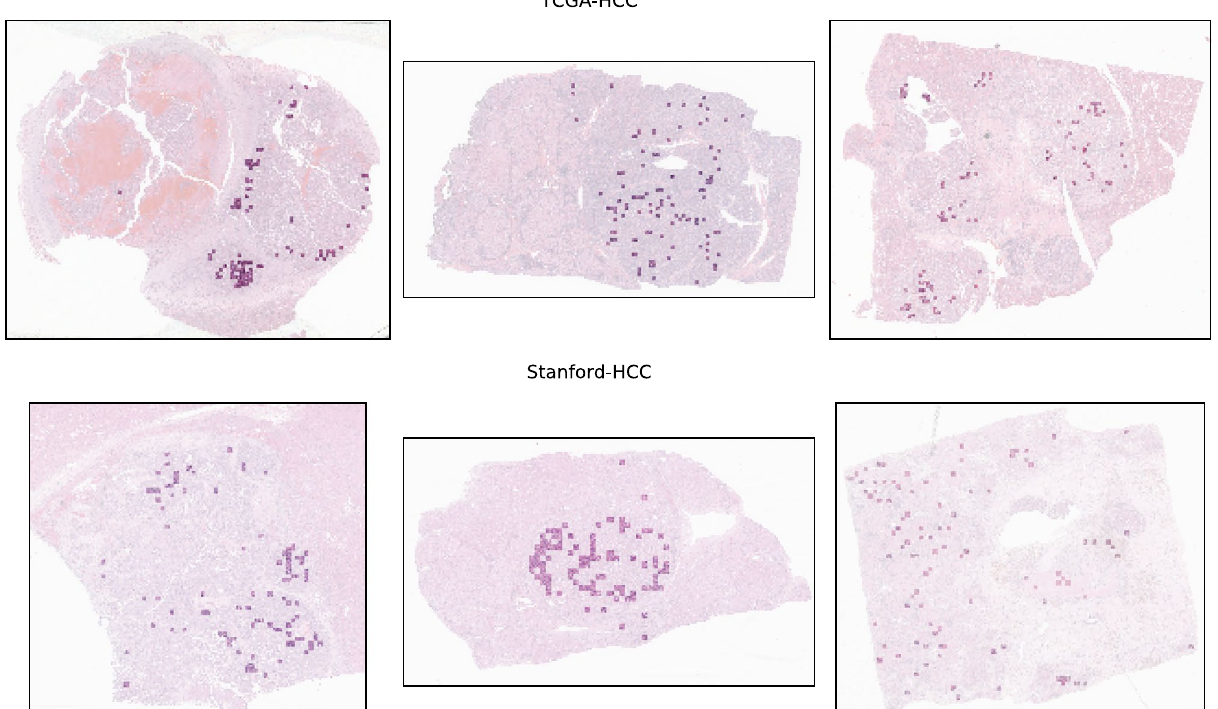
Figure 4. Top 100 tiles selected by the tumor tile classification model. Spatial distribution of the top 100 tiles classified as being tumor tiles by the tumor tile classification model. The top row represents examples from the TCGA-HCC test dataset, and the bottom row represents examples from the Stanford-HCC dataset. The top 100 tiles were subsequently used for development of the survival prediction model. WSI, whole-slide image.